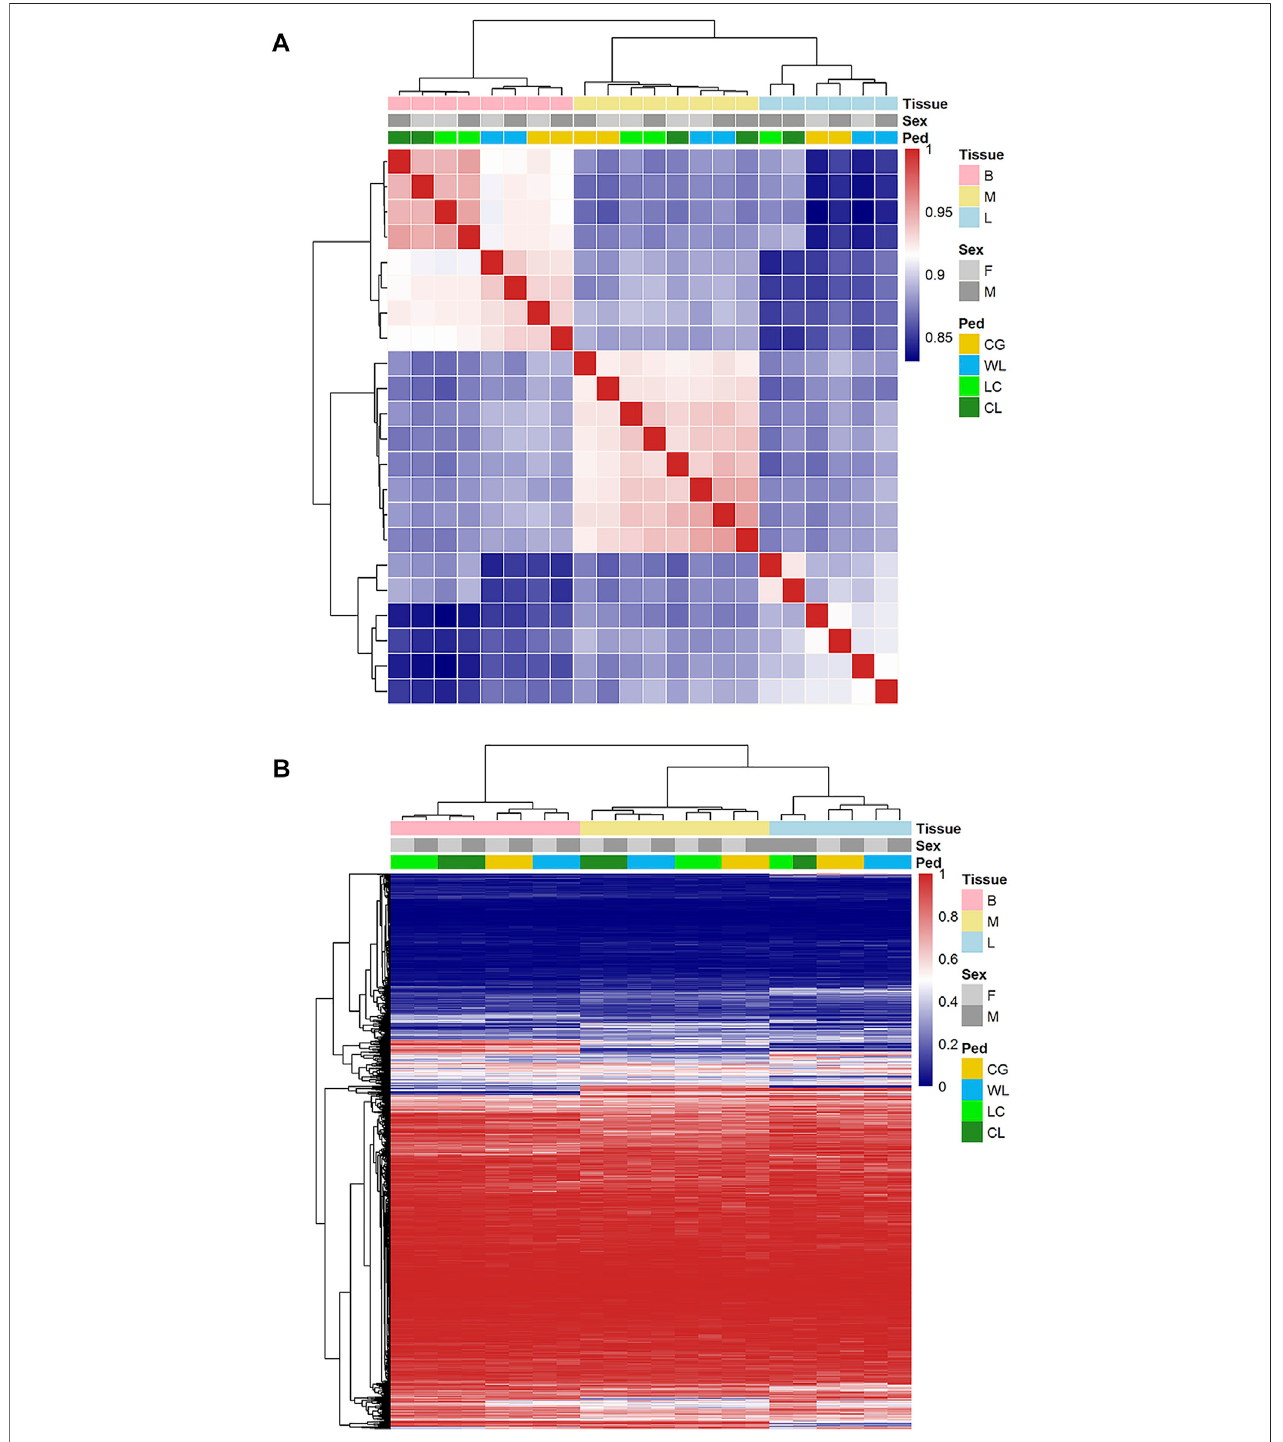
FIGURE5| Correlationsand hierarchical clusteringofalternativesplicing. (A) Spearman correlation basedonalternativesplicing(PSI)expressed inbrain,liver,and muscle. (B) Hierarchical cluster for AS events in each group.